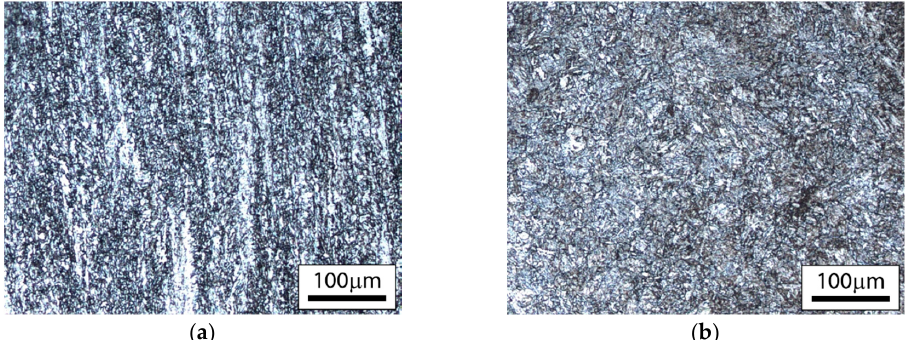
Figure 4. Micrographs of ( a ) API 5L X80 and ( b ) AISI 4137 steels, showing characteristic features.